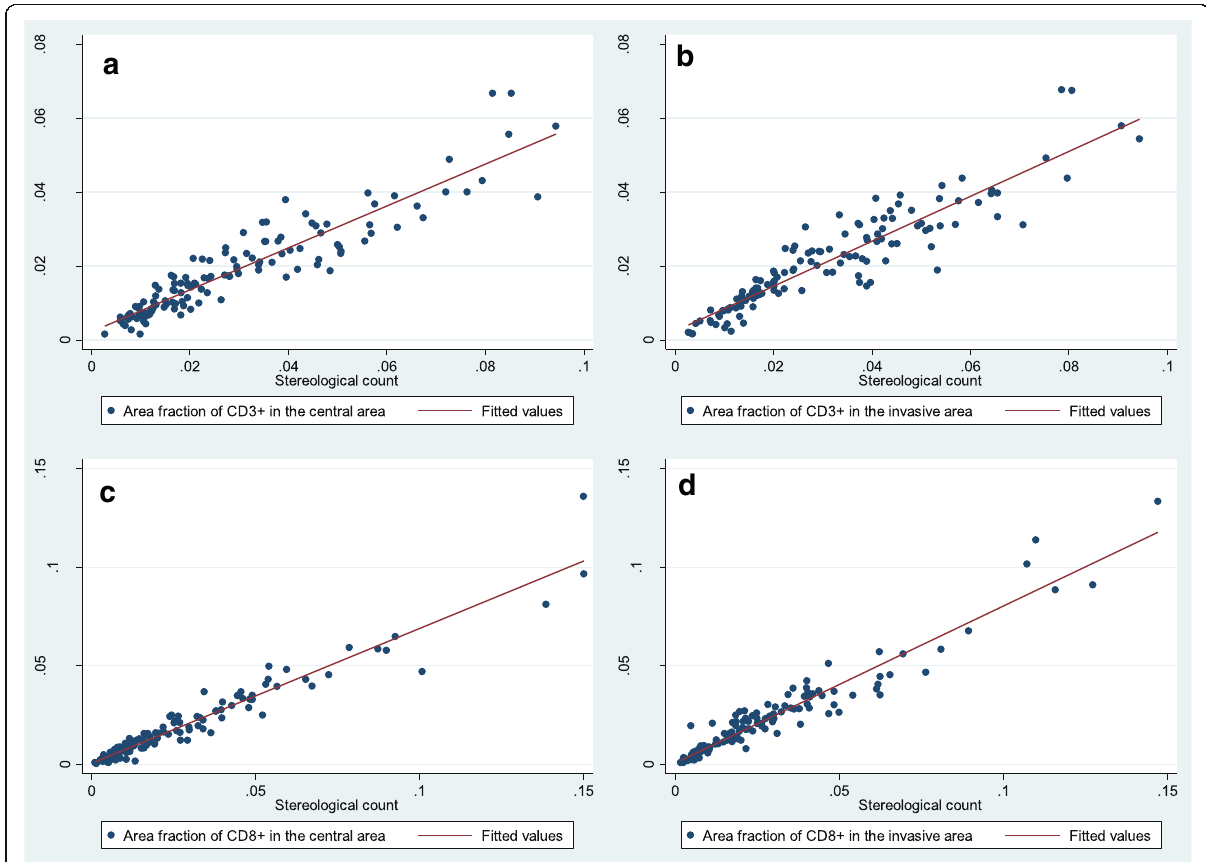
Fig. 7 Correlation between area fractions as estimated by stereology and image analysis. a ) Correlation for CD3+ tumor infiltrating lymphocytes (TILs) area fraction in the central tumor area. b ) Correlation for CD3+ TILs area fraction in the invasive tumor front. c ) Correlation for CD8+ TILs area fraction in the central tumor area. d ) Correlation for CD8+ TILs area fraction in the invasive tumor